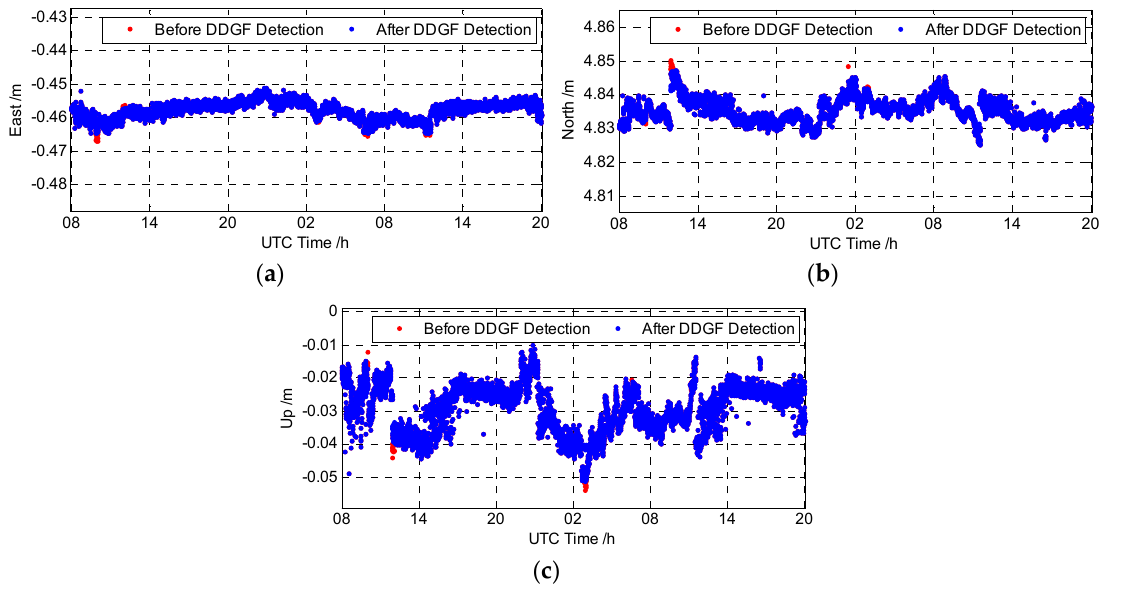
Figure 9. The baseline vector of the open sky test ( a ) East; ( b ) North; ( c ) Up.